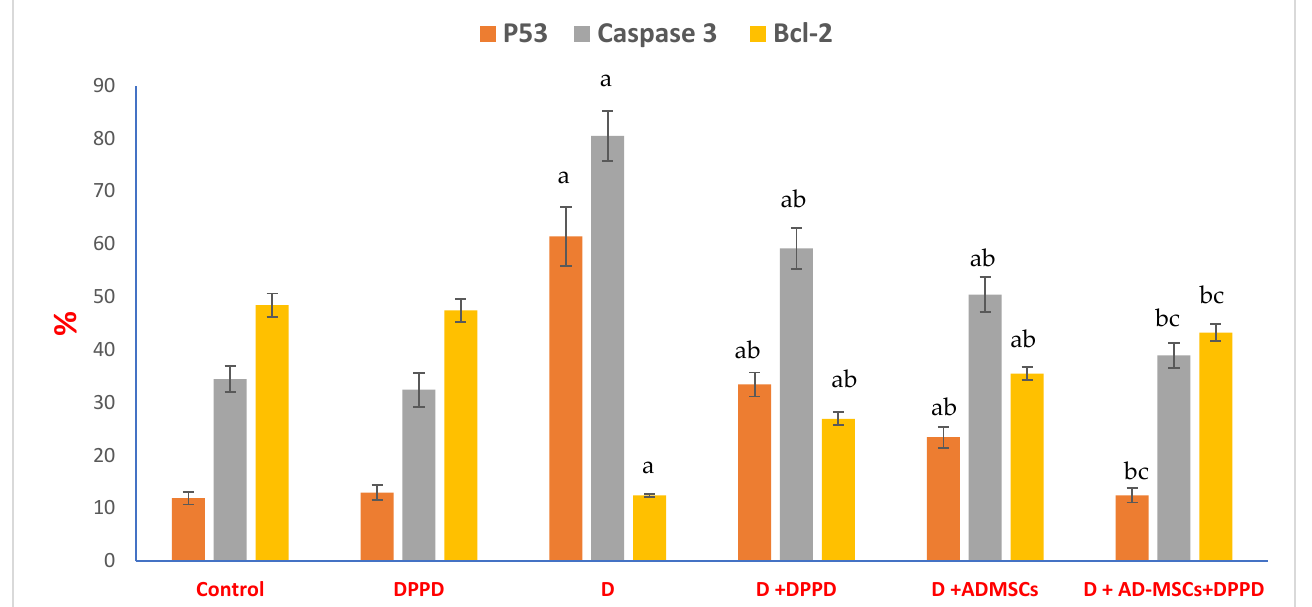
Figure 7. Pancreatic P53, caspase 3, & Bcl ‐ 2%. Values expressed as ± SEM ( n = 6). a, b & c are Significant differences ( p ≤ 0.05) compared to control, diabetic untreated and DPPD ‐ diabetic treated groups, respectively. % is the percent of change compared to the diabetic group.